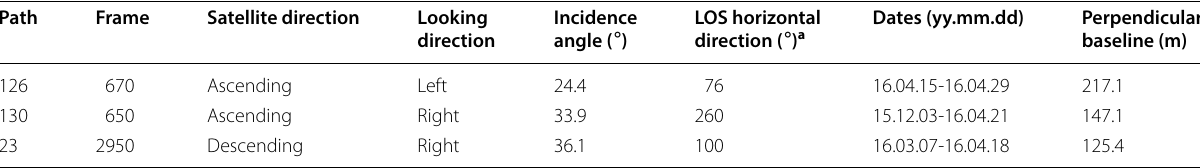
a Direction ground to satellite, measured clockwise from North